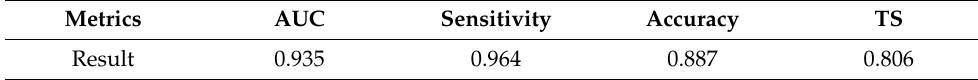
Figure 12. ROC curve and prediction rate for LR model. Table 4. Validation results of LR model prediction